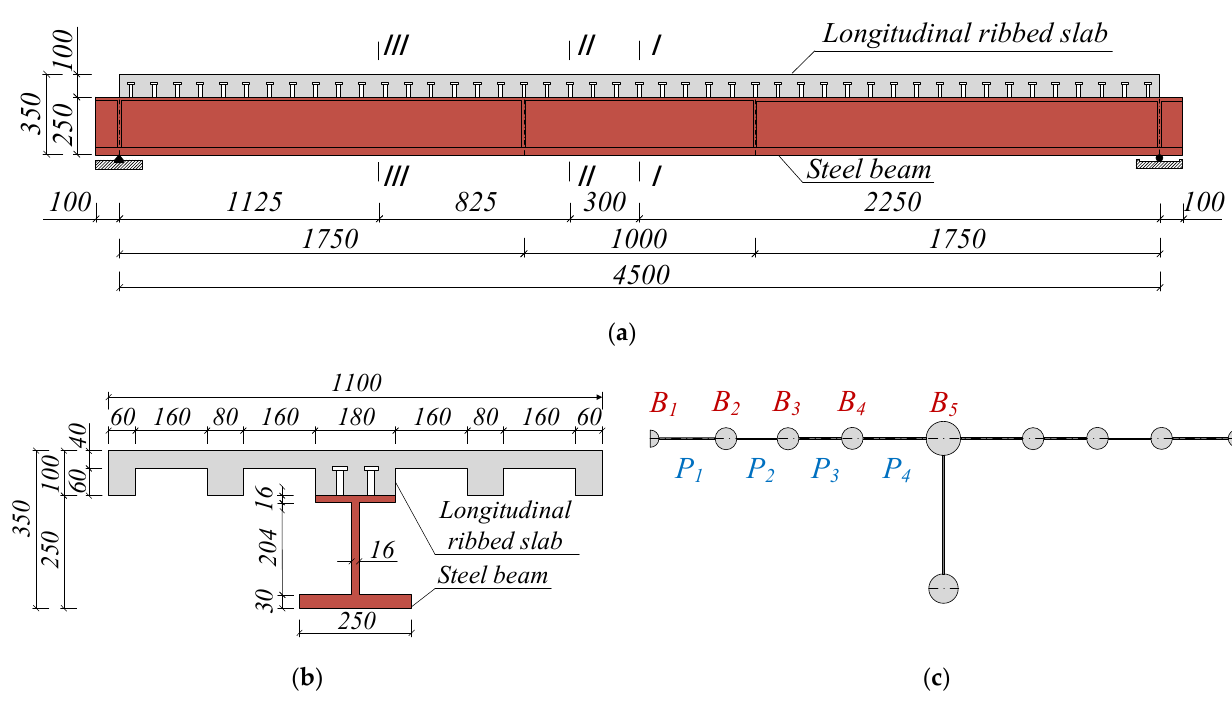
Figure 8. Dimension of SU-LRSCS specimen (unit: mm): ( a ) elevation; ( b ) cross section; ( c ) simplified structure.